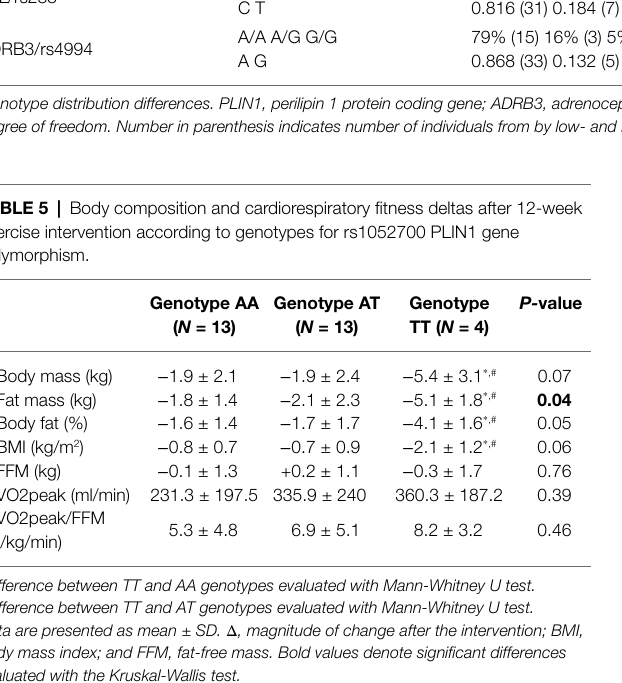
* Difference between TT and AA genotypes evaluated with Mann-Whitney U test. # Difference between TT and AT genotypes evaluated with Mann-Whitney U test. Data are presented as mean ± SD. Δ , magnitude of change after the intervention; BMI, body mass index; and FFM, fat-free mass. Bold values denote significant differences evaluated with the Kruskal-Wallis test.